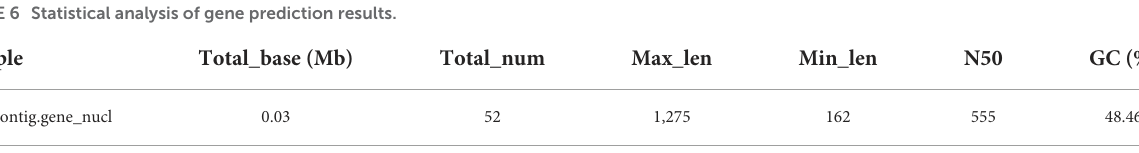
TABLE 6 Statistical analysis of gene prediction